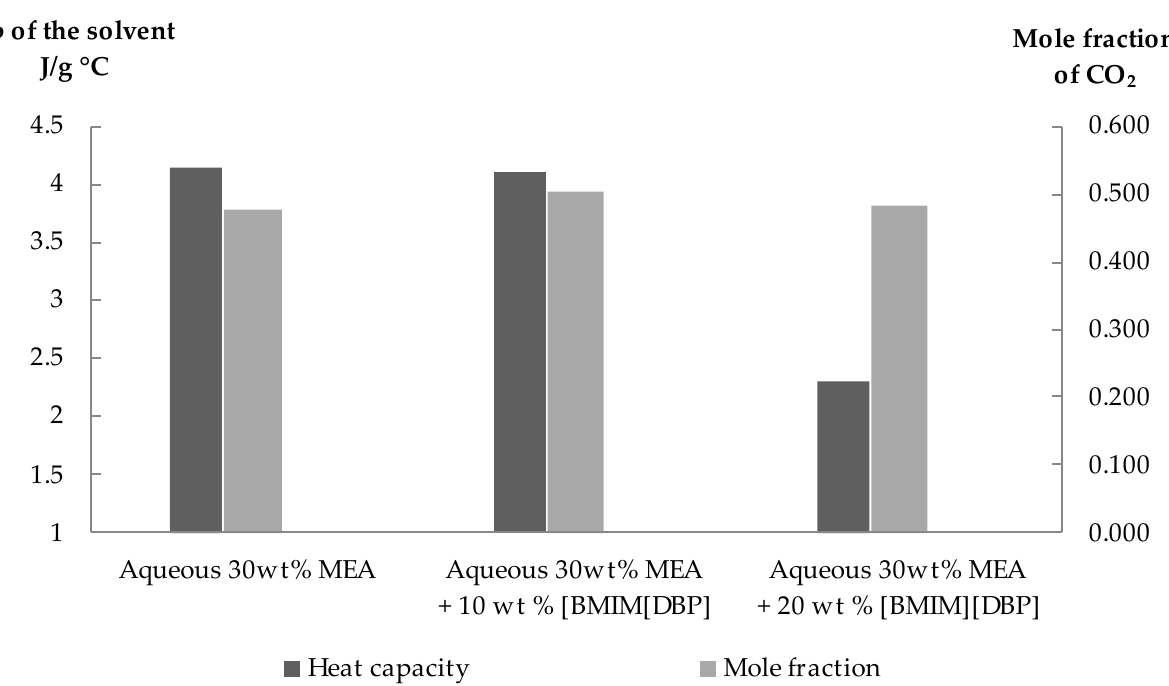
Figure 4. Heat capacity and CO 2 absorption of MEA-(BMIM)(DBP) hybrid solvent. CO 2 absorption measurement was carried out at 30 °C and 30 bar.